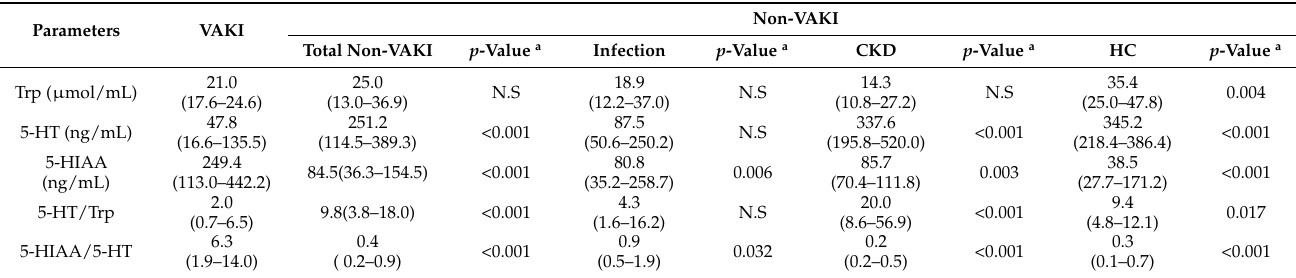
Table 3. Comparison of serum tryptophan, serotonin, and 5-HIAA concentration between the VAKI group and non- VAKI groups.